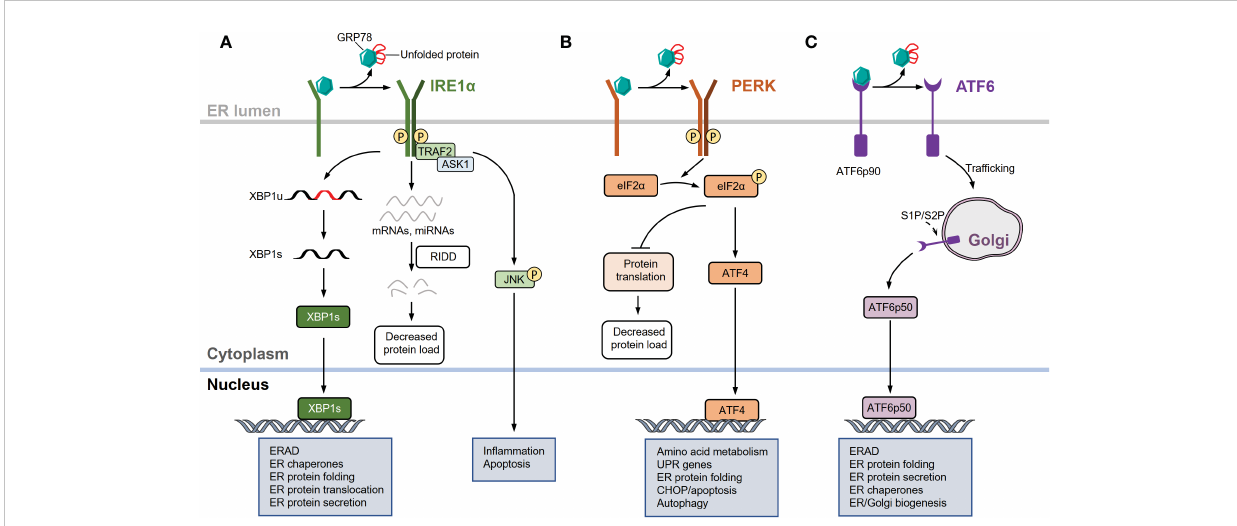
FIGURE 1 UPR signaling pathways. (A) Inositol-requiring enzyme 1 (IRE1 a ) signaling arm of the unfolded protein response (UPR). In response to endoplasmic reticulum (ER) stress, IRE1 a is activated through dissociation from glucose- regulated protein 78 (GRP78), oligomerization, autophosphorylation, and subsequent allosteric activation of the cytosolic endonuclease domain. Activated IRE1 a facilitates the unconventional splicing of XBP1 ( XBP1u ) mRNA, resulting in active transcription factor XBP1s, which drives the expression of genes involved in restoring ER homeostasis. IRE1 a also degrades select mRNAs and miRNAs through regulated IRE1-dependent decay (RIDD) to reduce protein load in the ER during intensive ER stress. In response to severe or unresolved ER stress, activated IRE1 a recruits and binds to tumor necrosis factor receptor-associated factor 2 (TRAF2) and apoptosis signal-regulating kinase 1 (ASK1) to promote c-Jun N-terminal kinase (JNK) signaling, leading to the activation of apoptosis. (B) Protein kinase R (PKR)-like ER kinase (PERK) arm of the UPR. In response to ER stress, PERK is activated by dissociating from GRP78 and auto-phosphorylating after dimerization. Activated PERK selectively phosphorylates eukaryotic translation initiation factor 2 subunit- a (eIF2 a ), thereby attenuating protein translation. The mRNA of activating transcription factor 4 (ATF4) is preferentially translated following eIF2 a phosphorylation, allowing it to upregulate genes involved in restoring ER homeostasis, amino acid metabolism, apoptosis, and autophagy. (C) Activating transcription factor 6 (ATF6) arm of the UPR. In response to ER stress, GRP78 dissociates from the luminal domain of full-length of ATF6 (ATF6p90), allowing ATF6 monomers to traf fi c to the cis-Golgi apparatus where they are proteolytically processed and cleaved by site-1 protease (S1P) and site-2 protease (S2P). This releases an active ATF6 transcription factor fragment (ATF6p50). The transcription factor localizes to the nucleus, inducing several genes involved in restoring ER homeostasis and ER/Golgi